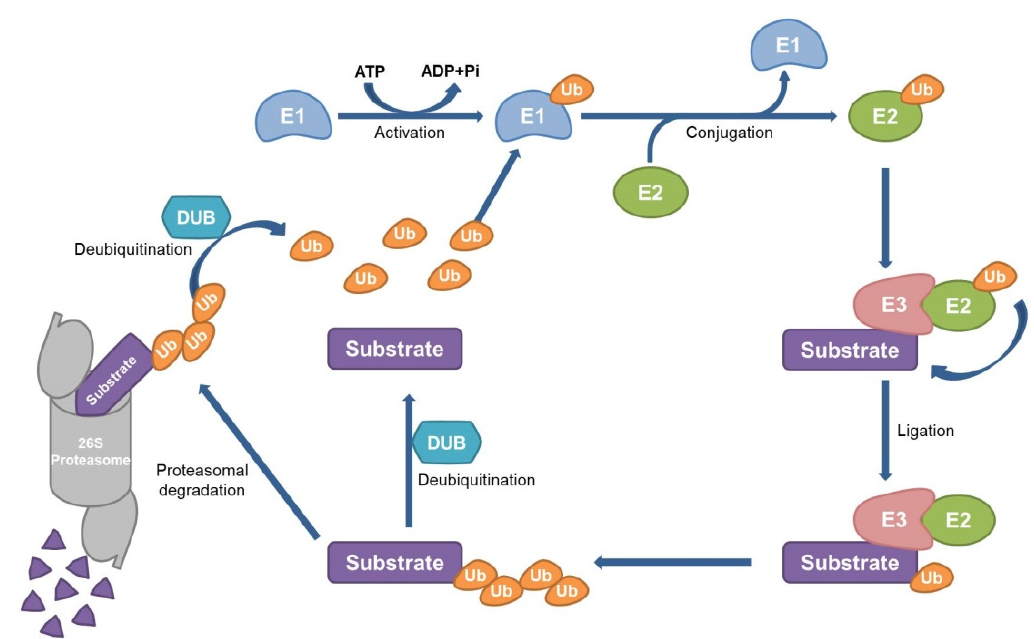
Figure 2. The schematic diagram of the ubiquitin–proteasome system (UPS). The ATP-activated E1 enzyme binds to glycine at the end of ubiquitin. The E1 enzyme delivers the ubiquitin to the E2 enzyme. The E2 enzyme binds to the E3 enzyme (E3 ligase) bound to the substrate protein. Ubiquitin linked to the E2 enzyme moves to the substrate protein. By repeating this process, several ubiquitins form a polyubiquitin chain, and the substrate is degraded through the 26S proteasome. Deubiquitinating enzyme (DUB) acts in opposition to the E3 ligase, which links ubiquitin to the substrate protein.